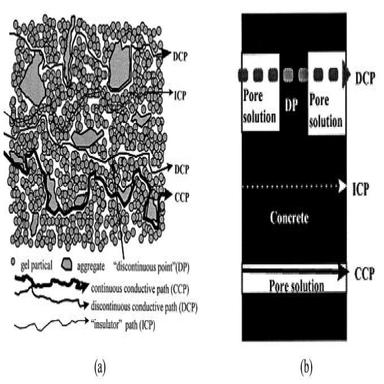
(a) Schematic representation and (b) simplified model of microstructure of concrete.